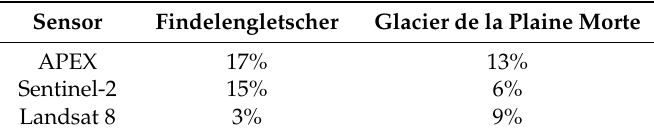
Table A1. Glacier-wide average statistic values of the impact of anisotropy correction (SBA ani minus SBA iso ) on albedo products from different datasets for Findelengletscher and Glacier de la Plaine Morte derived with the SBA algorithm.